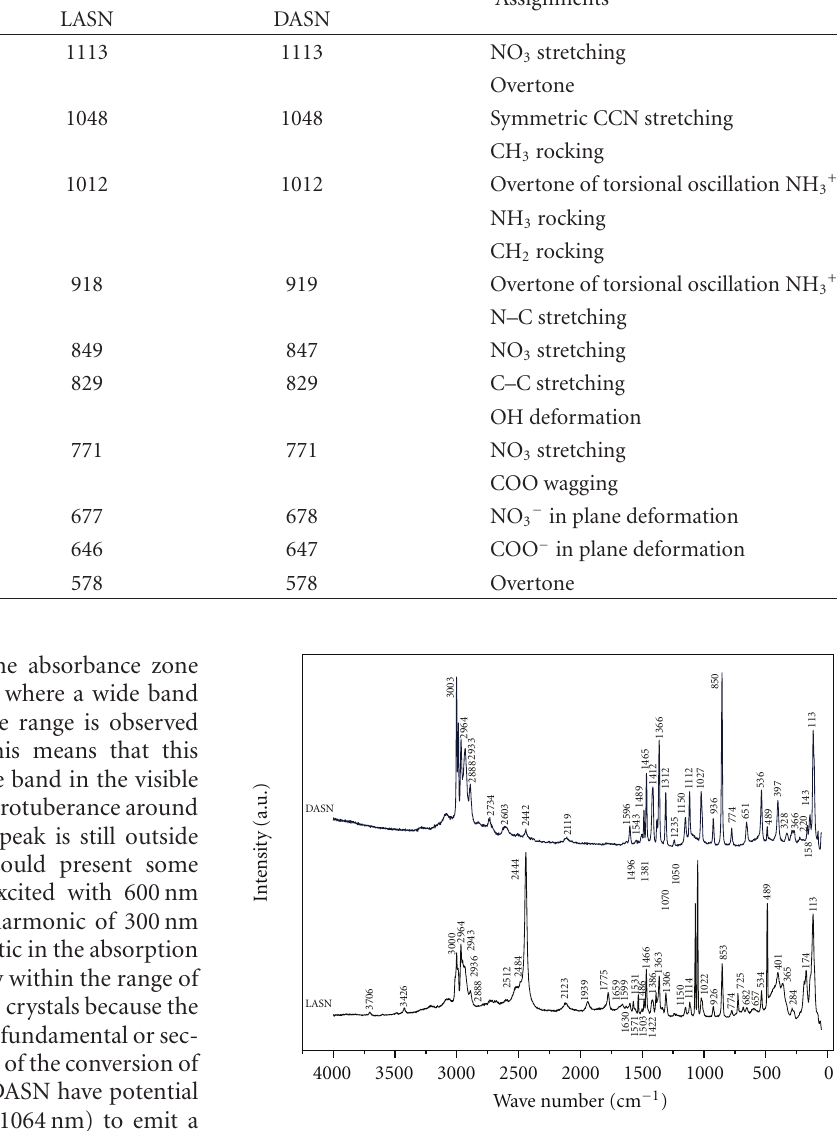
Figure 4: Raman spectrum of LASN and